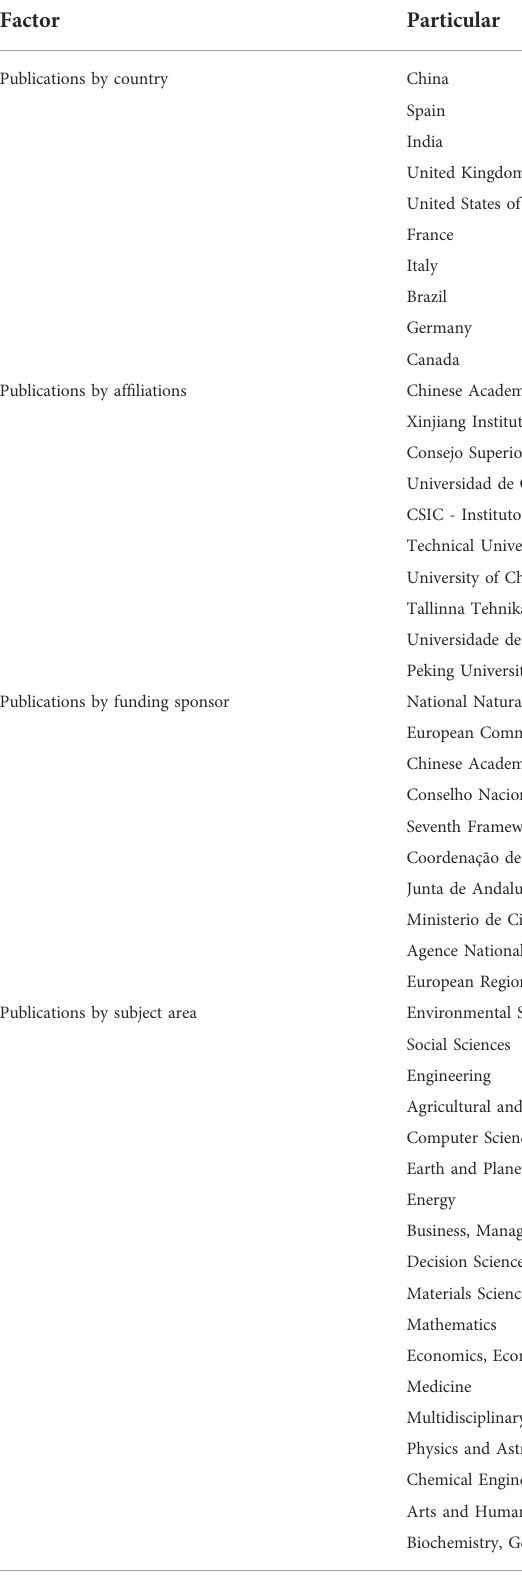
TABLE 1 Most proli fi c stakeholders of green corridor